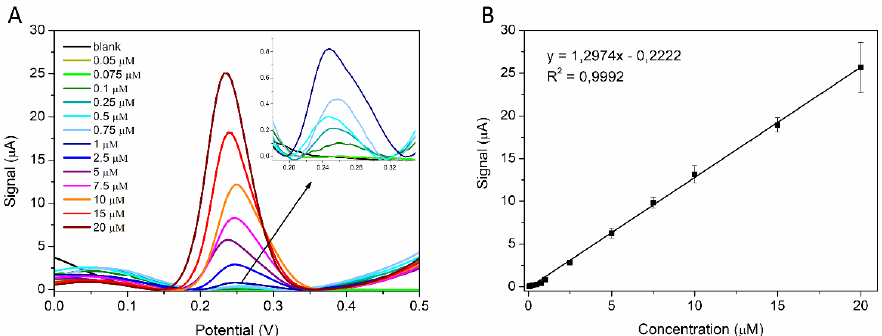
Figure 6. ( A ) The DPV analyses of PQS solutions at different concentrations (50 nM, 75 nM, 100 nM, 250 nM, 500 nM, 750 nM, 1 µ M, 2.5 µ M, 5 µ M, 7.5 µ M, 10 µ M, 15 µ M, and 20 µ M); ( B ) linear fitting of 250 nM, 500 nM, 750 nM, 1 µM, 2.5 µM, 5 µM, 7.5 µM, 10 µM, 15 µM, and 20 µM); ( B ) linear fitting of the peak height and the concentration of PQS. the peak height and the concentration of